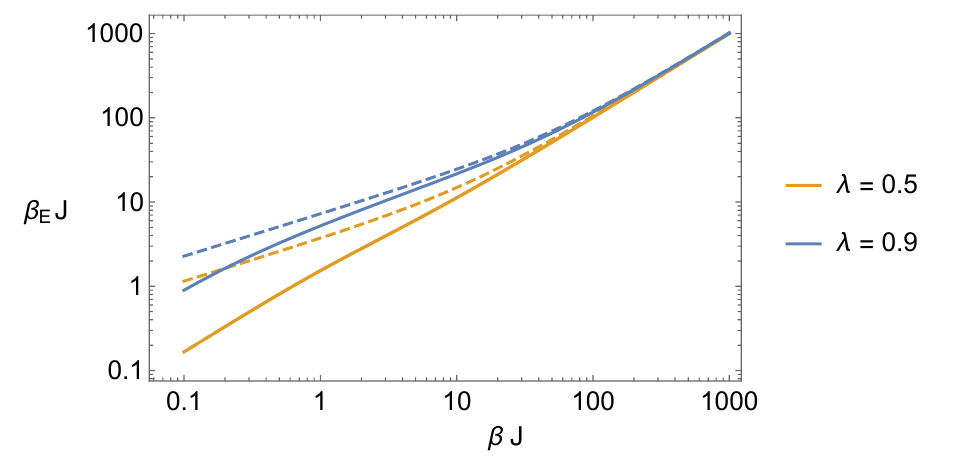
Figure 13 . The effective inverse temperature β E as a function of β in units of J . We show the results for λ = 0 . 9 and λ = 0 . 5 . The dashed lines are the Schwarzian predictions given by (3.44). At very large β J , the growth is approximately linear β E ≈ β